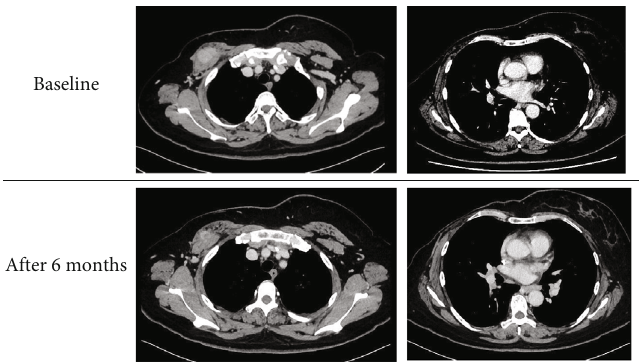
Figure 1: At baseline, computed tomography (CT) shows the appearance of the right subpectoral lymph node metastasis (3.6 cm diameter). After 6 months, CT showed further reduction of that lesion, while the right hilar lymph nodes are enlarged. Table 1: Laboratory tests on nodule